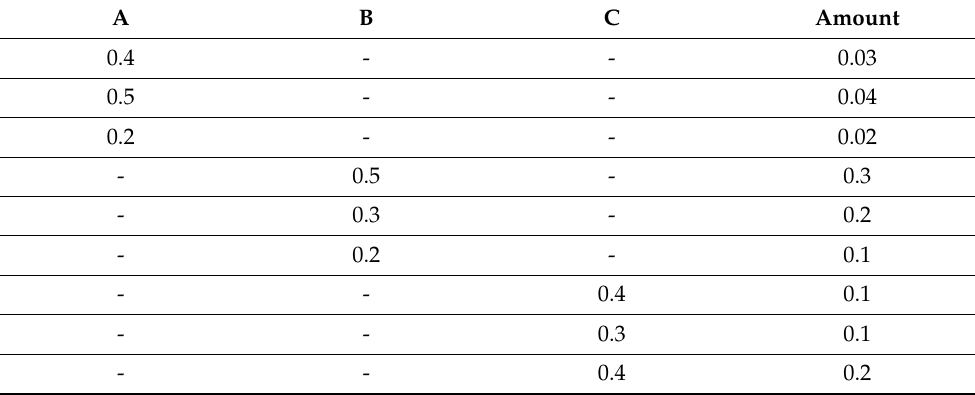
Table 4. Calculation of the matrix of resource-saving